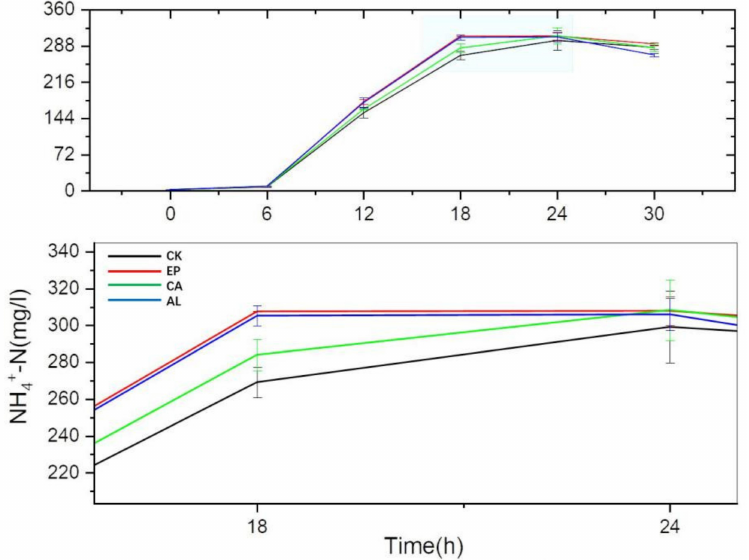
Figure 6. The changes of NH 4+ -N concentration with culture time. The TN-N were decreased continuously in all treatment groups and the control group before 18 h (Figure 7), while the TN-N of all the groups reached their minimum value at 18 h except for the CA group, and the TN-N content began to increase after 18 h; this might be related to the release of intracellular substances of dead cell. At 12 h, the TN-N content of the CK group was higher than the treatment groups, which might indicate that the addition of seaweed polysaccharides promoted the secretion of extracellular substances, such as enzyme proteins and polysaccharides, etc. The TN-N of the EP treatment group reached the lowest content at 18 h, followed by CK, AL and CA, whose concentrations were 363.28 ± 2.54, 374.07 ± 13.68, 375.34 ± 5.29 and 402.83 ± 1.90 mg/L, respectively. This might be related to the fact that EP stimulated BS to remove nitrogen faster and